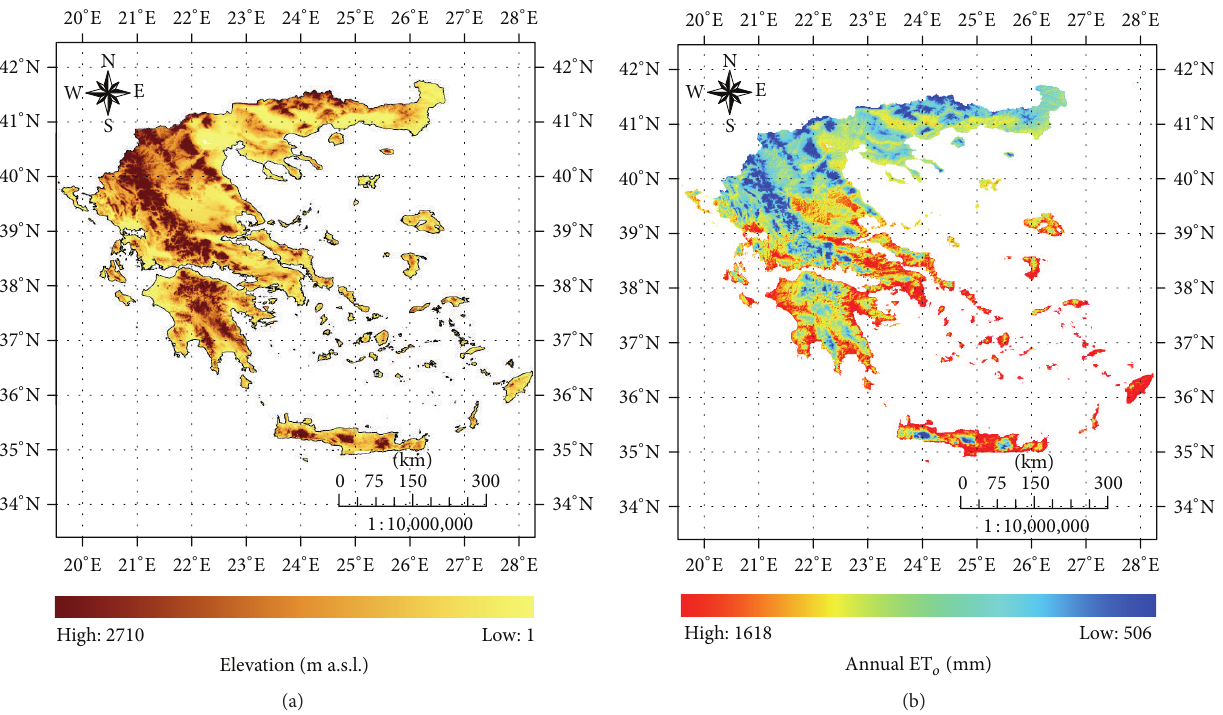
Figure 1: Maps of (a) elevation 𝐻 and (b) mean annual ET 𝑜 for the period 1950–2000 estimated by the ASCE standardized Penman-Monteith